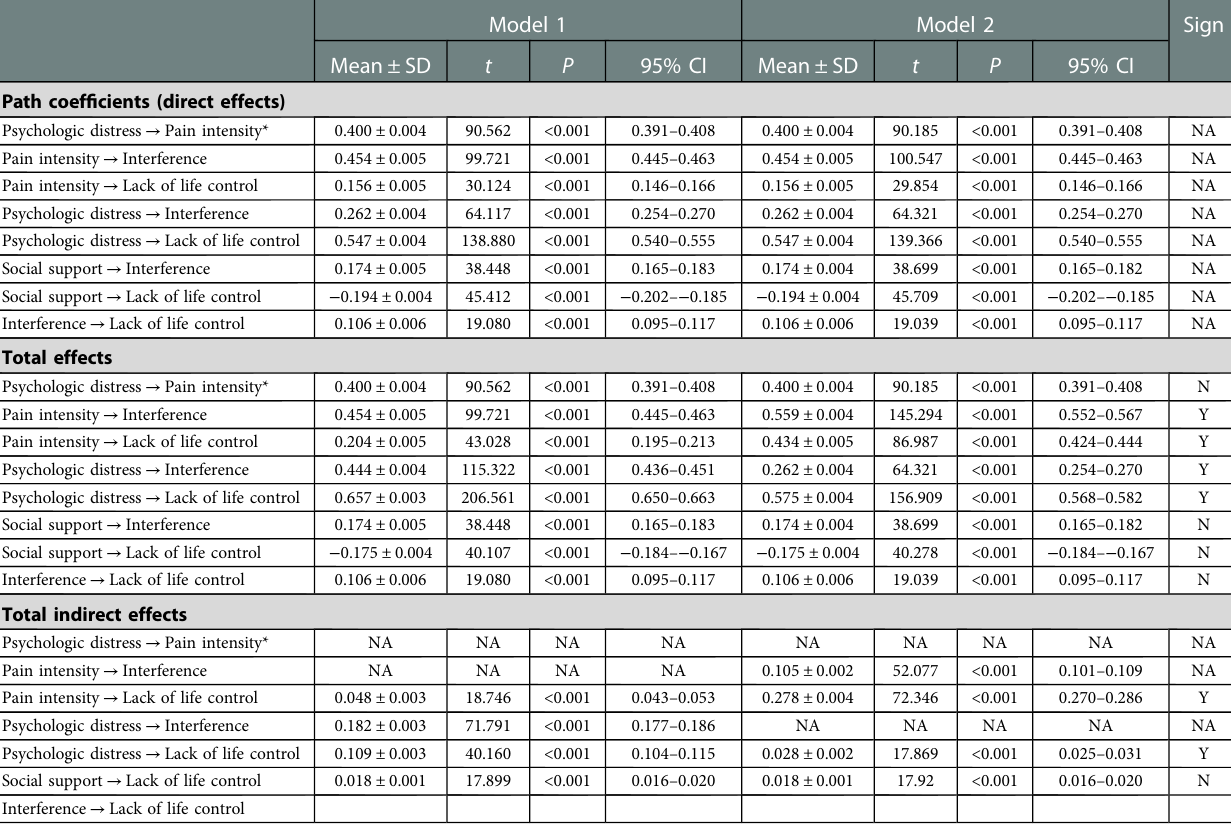
TABLE 4A Path coef fi cients (direct effects), total and total indirect effects for the two models of the total cohort ( N =40,184). In model 1, psychological distress → Pain intensity and in model 2 the opposite (i.e., Pain intensity → Psychological distress). Mean±SD, t -values, P -values, and 95% con fi dence intervals (95% CI) are